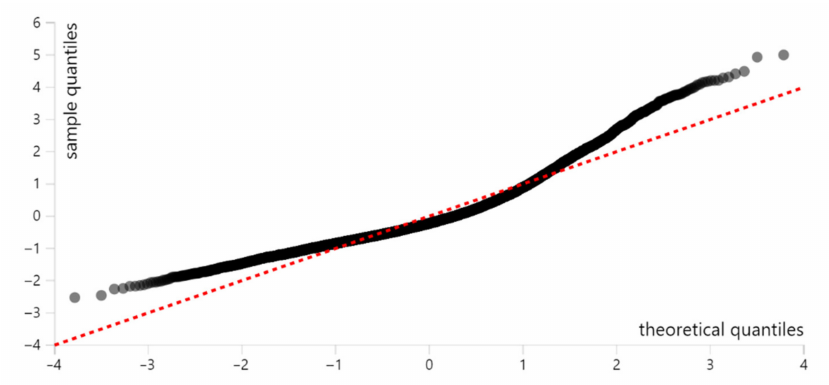
Figure A3. Quantiles distribution.